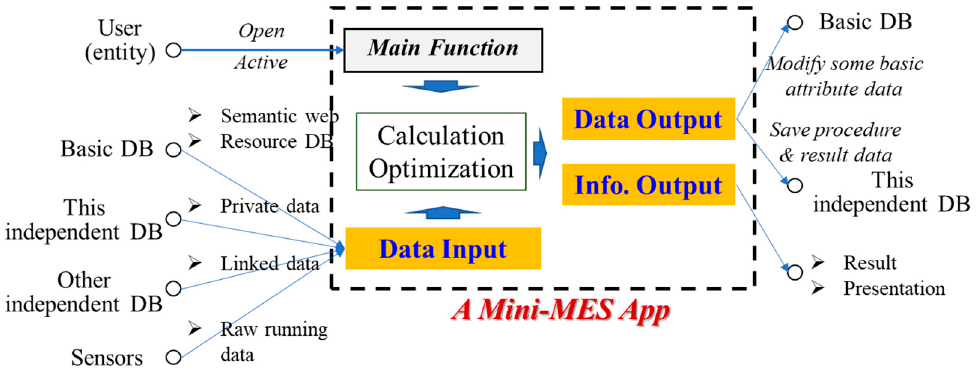
Figure 4. Input & Output of an M 2 ES App.